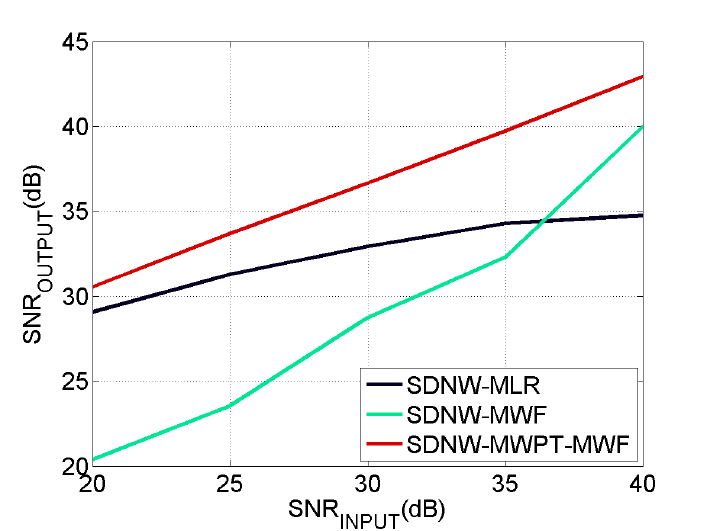
Figure 11. Comparison of denoising results based on SNR OUTPUT versus SNR INPUT .